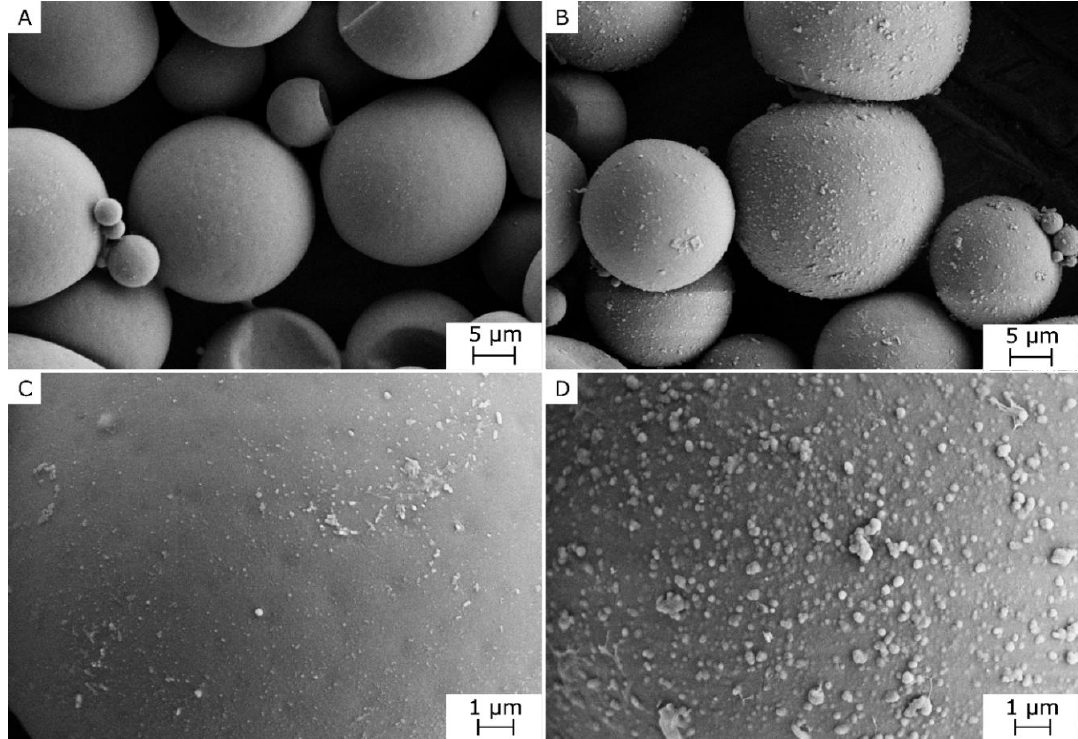
Figure 1. SEM micrographs of the external surface of neat and PDA-coated microcapsules at different magnification levels. ( A , C ) Neat microcapsules, MC; ( B , D ) PDA-coated microcapsules, MC-PDA.